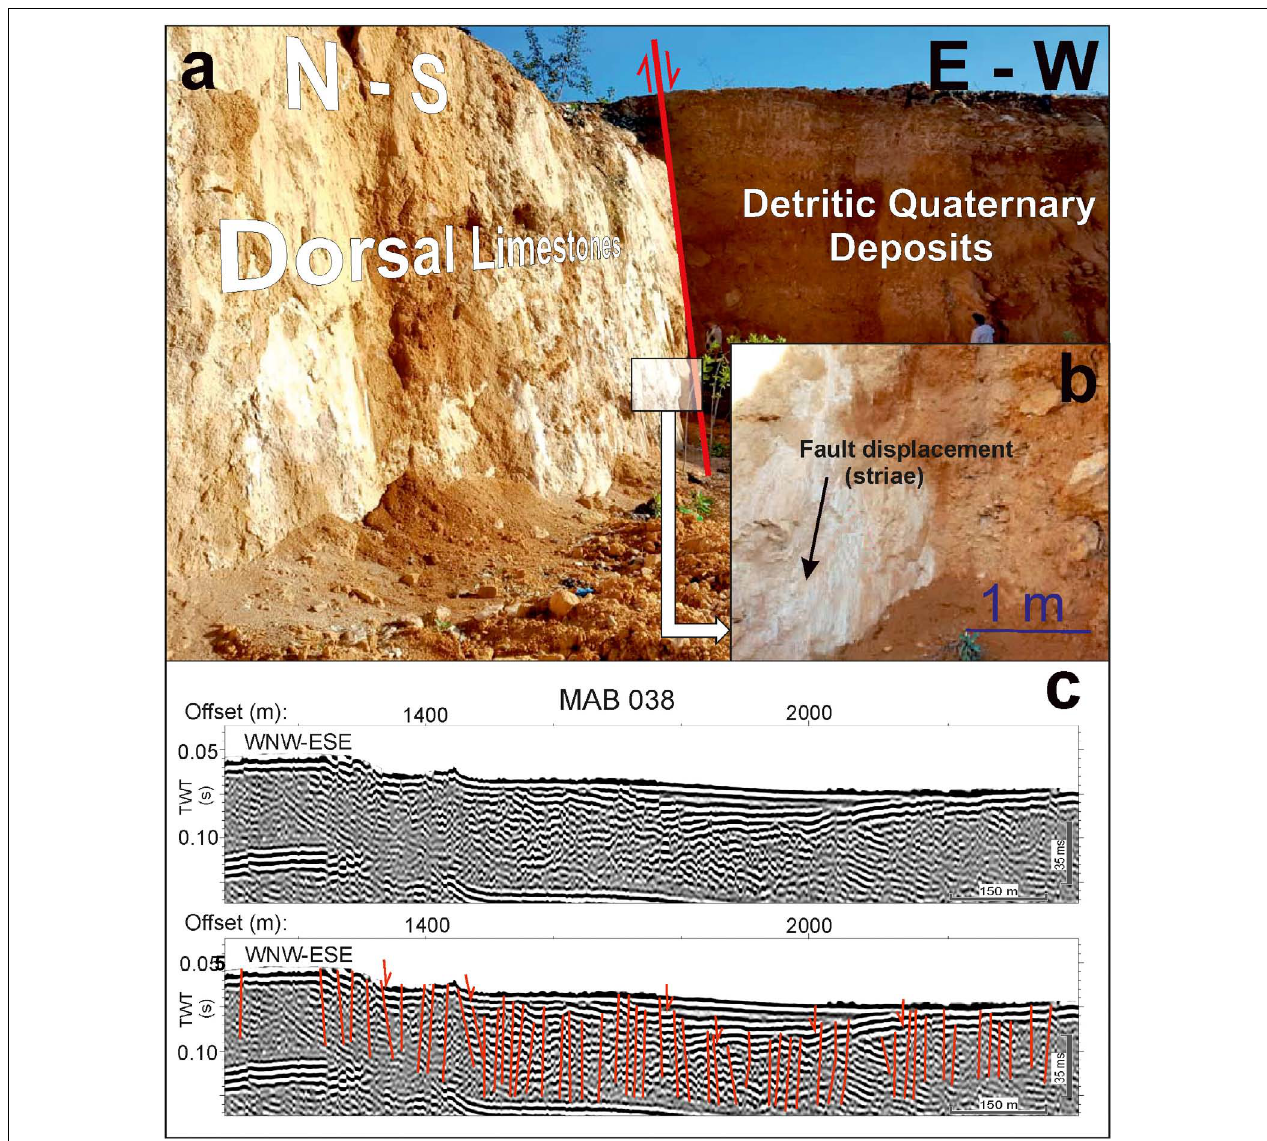
FIGURE 7 | Onshore–offshore link in the Al Hoceima region with the illustration of the onshore Sidi Abed normal fault and the offshore Bokkoya normal faults. (a) Normal fault in the Sidi Abed area that affects the local Quaternary deposits. Fault orientation and dipping are N000 ◦ E /80 ◦ W. (b) Detail of the fault plane; the black arrow marks the orientation and sense of the striae. (c) The uninterpreted and interpreted seismic reflection profile MAB 038 showing normal faults (lines in red) that are associated to the onshore faults of Sidi Abed and the offshore northeast and southwest (NE-SW) Bokkoya normal